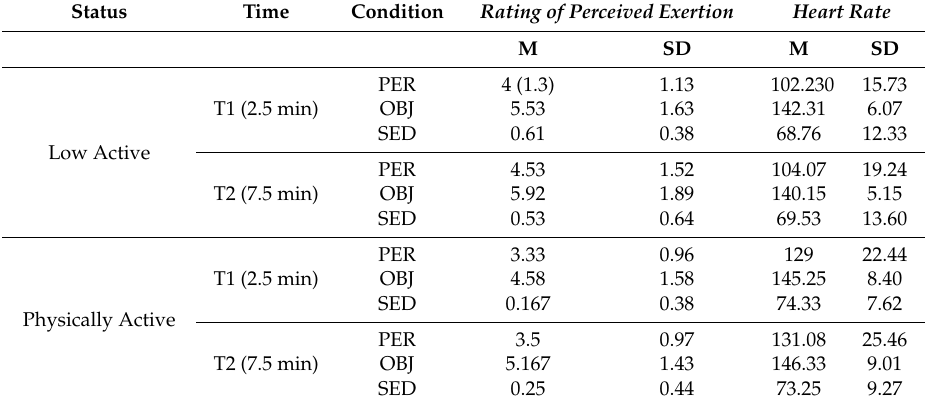
Figure 1. Mean values for item “I have a desire for a cigarette now” in all conditions. T1: Time 1—Baseline Table 3. Mean and standard deviation values for rating of perceived exertion and heart rate in all conditions.